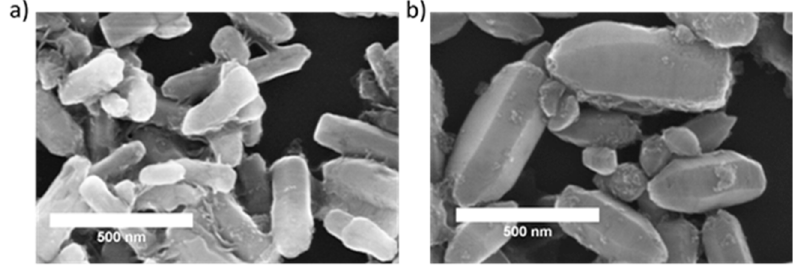
Figure 2. Scanning electron microscopy images of ZnO:Fe 3+ ( a ) and ZnO:Fe 3+,2+ ( b ) nanoparticle structures.